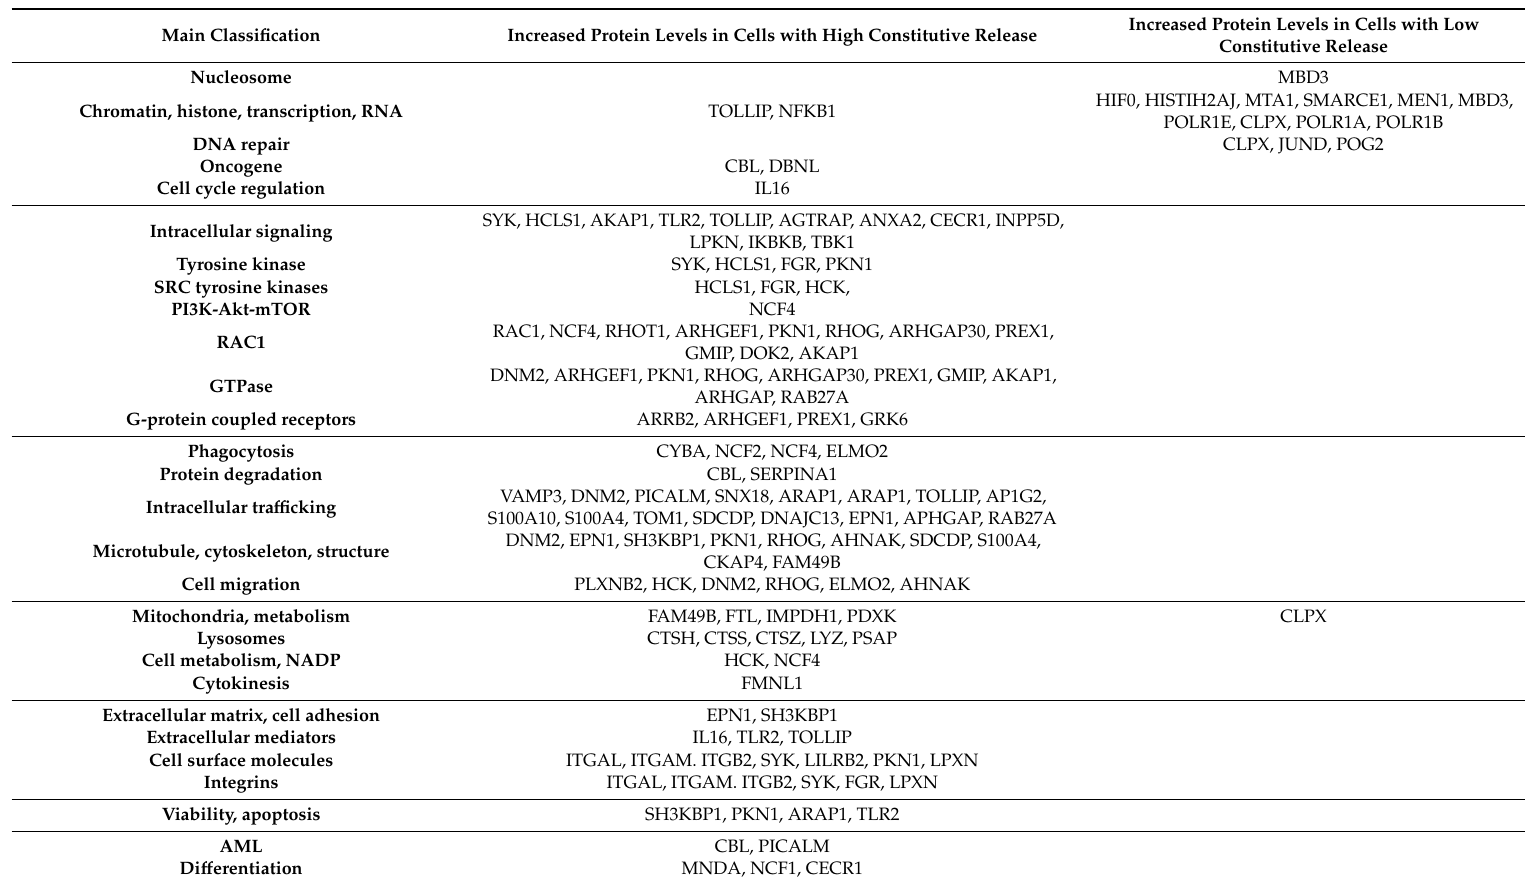
Table 3. Di ff erentially expressed proteins in primary AML cell populations with high (left) and low (high) constitutive release of extracellular soluble mediators. The mediators are classified based on their main functional characteristics. The information is based on the Gene database and selected references from the PubMed database (Table S4). The proteins being increased in high-secreting AML cells are those proteins that were both included in the gene ontology (GO) terms protein network in the left part of Figure 5 (Table S4). The proteins being increased in the low-secreting AML cells are those proteins included the GO